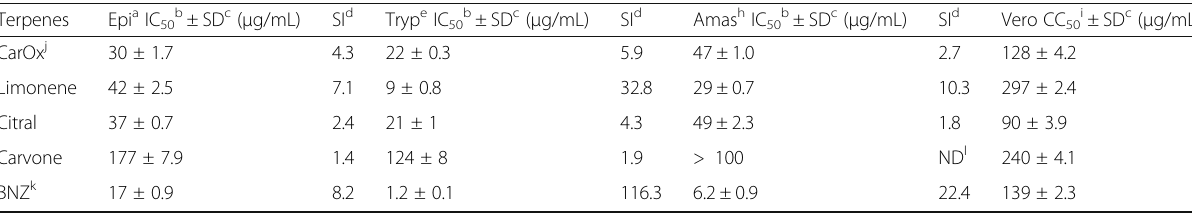
Table 5 Anti-parasitic effect on Trypanosoma cruzi of the major terpenes of Citral and Carvone chemotype L. alba essential oils